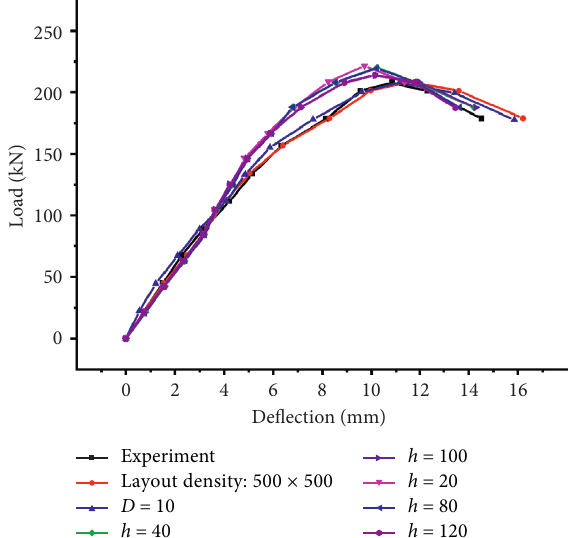
Figure 11: The load-deflection curves of different parameters of the tie